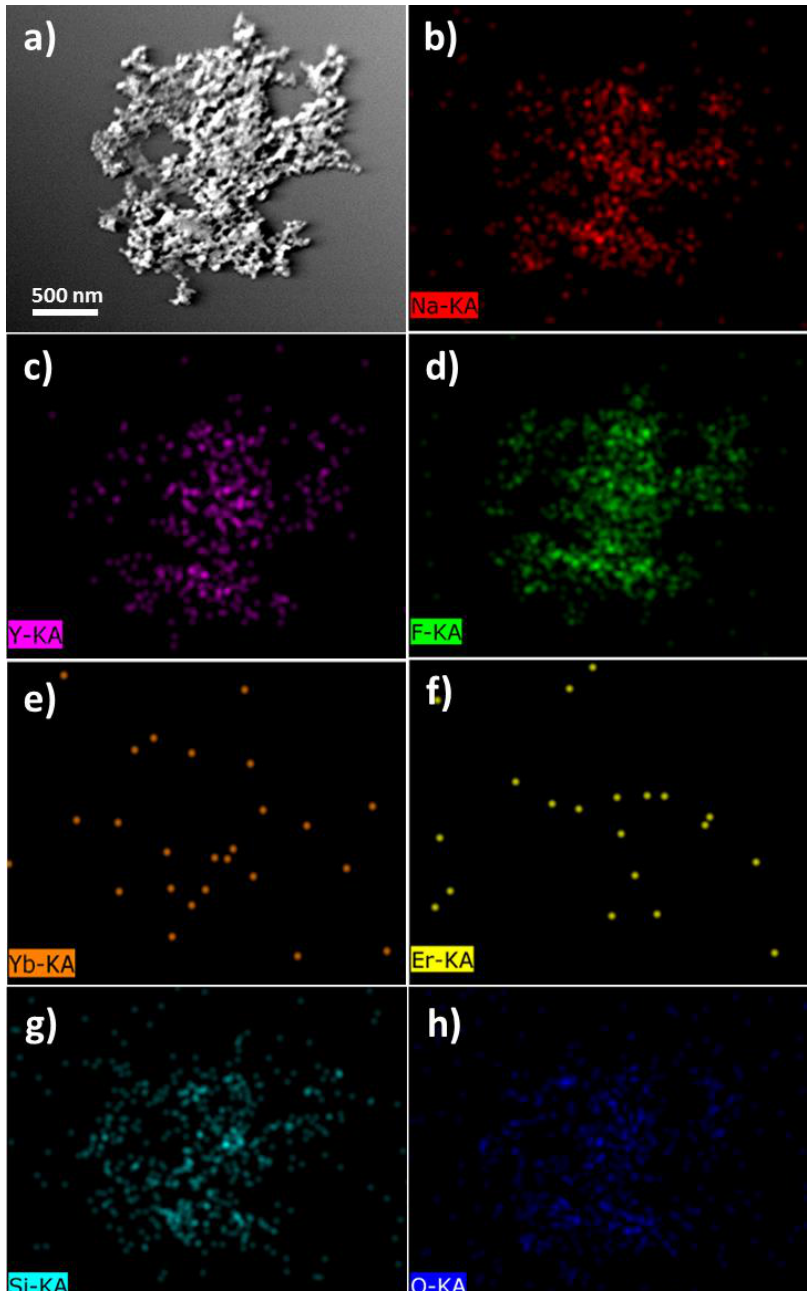
Figure 3. ( a ) STEM-HAADF image of UCNC@SiO 2 core-shell nanostructures with associated ( b ) sodium (Na), ( c ) yttrium (Y), ( d ) fluoride (F), ( e ) ytterbium (Yb), ( f ) erbium (Er), ( g ) silicon (Si), and ( h ) oxygen (O) elemental mapping.